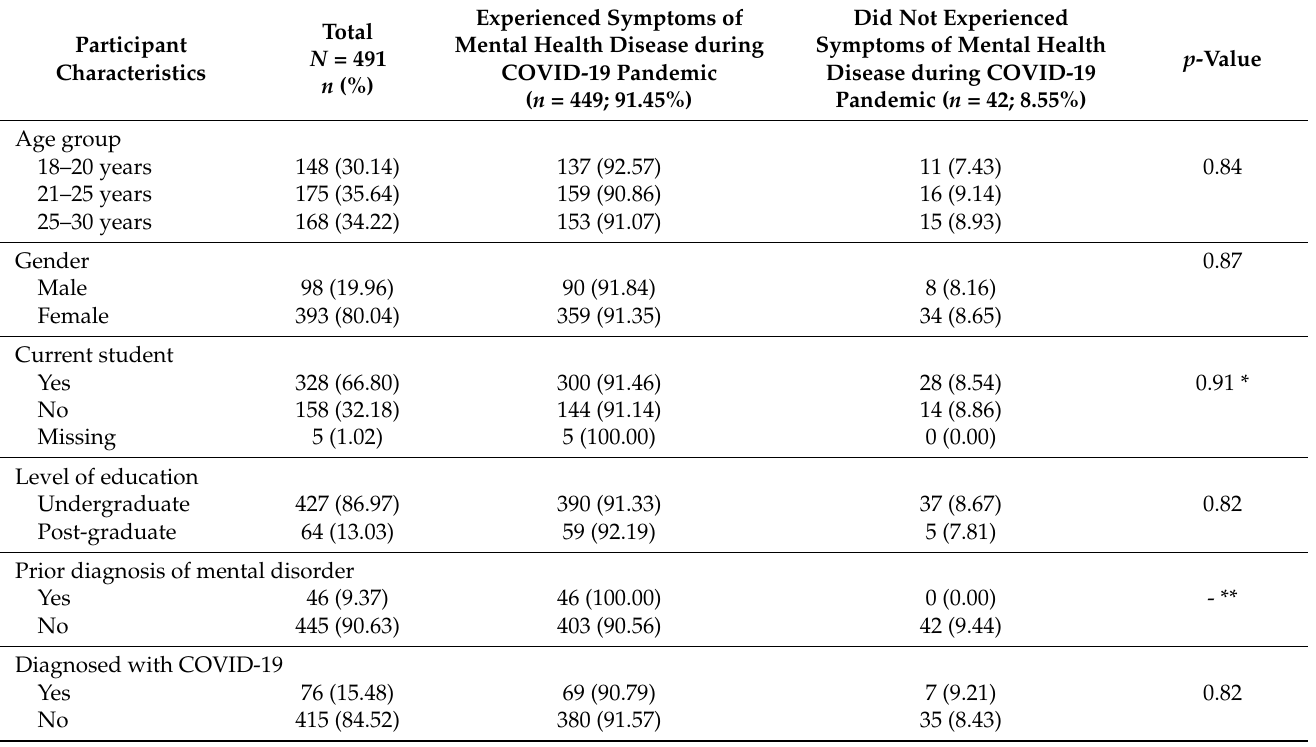
Table 2. Characteristics of emerging adults (aged 18–30 years) who completed the DSM 5 and ASQ survey questions, Saudi Arabia, 2020–2021.